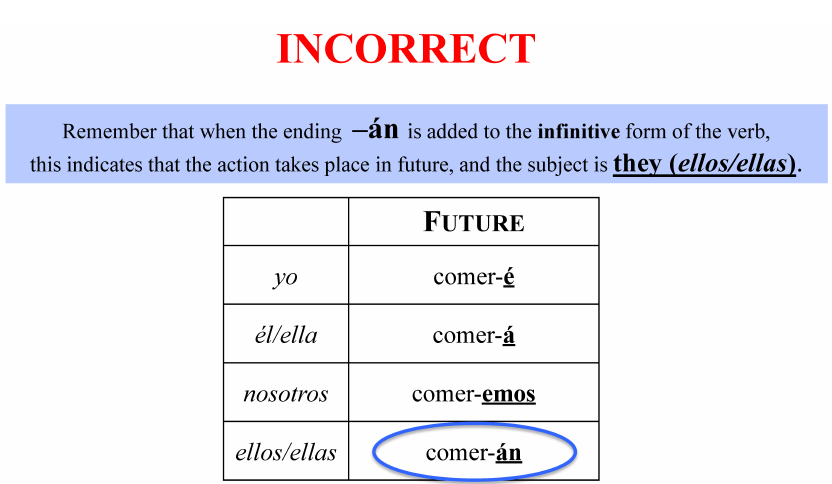
Figure 4. Example of Metalinguistic Feedback Following a Subject Question during Visual Training